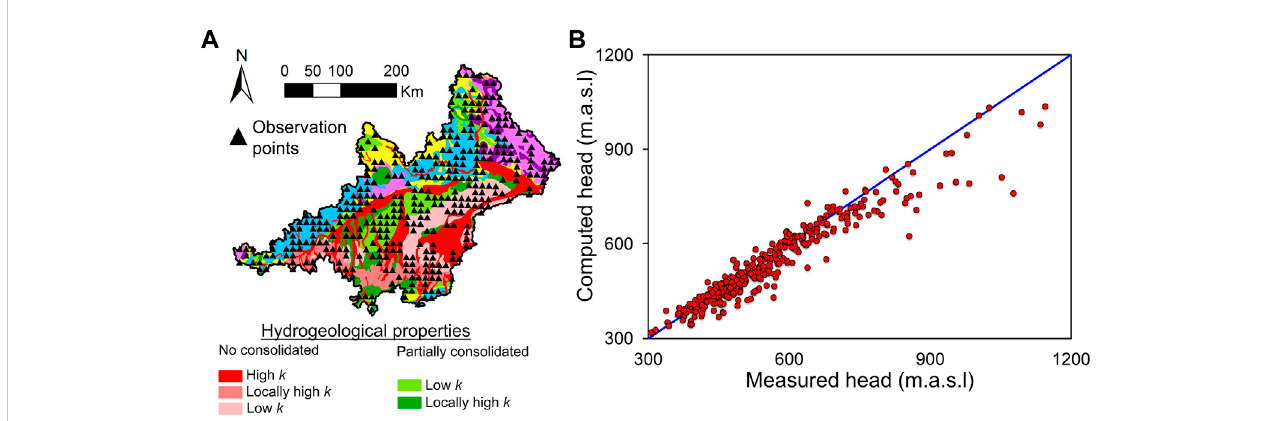
FIGURE 9 (A) Consideredpointstocalibrate themodel insteady state usingthetopographyas reference.These points,whicharechosenarbitrarily,aredistributed regularlythroughthemodeleddomain.Theheadassignedtothesepointstocalibratethelowerboundofthehydraulicconductivityisobtainedbysubtracting 2 mtotheelevationsurface.Despiteonepointevery8000 mischosen,thoselocatednearriversorstreamsareneglected; (B) Fittingbetweencomputedand measured heads derived from the topography.